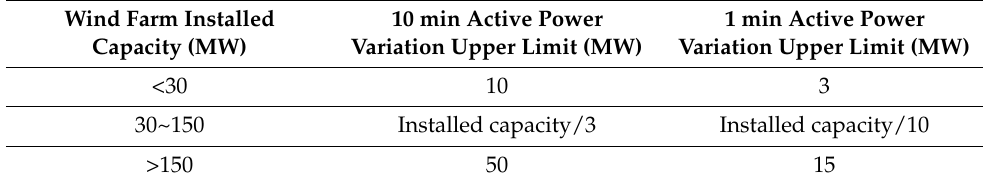
Table 1. Wind farm active power change limit recommended value